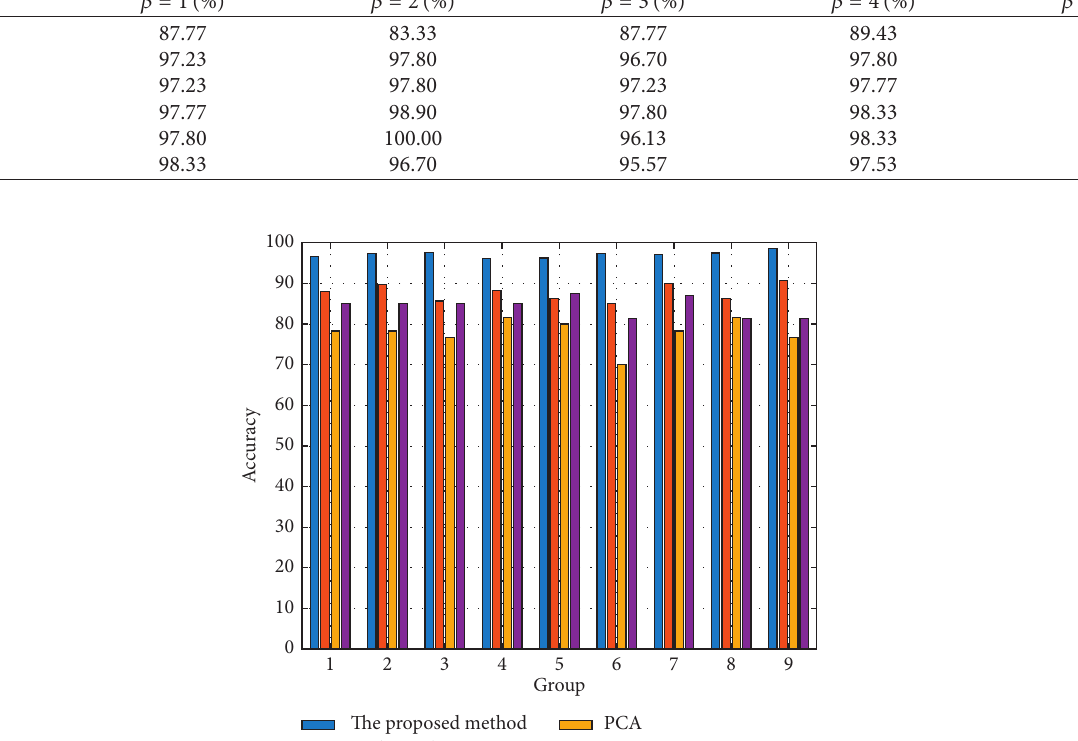
Table 6: Classification accuracy for parameters combinations in unknown working conditions. Accuracy